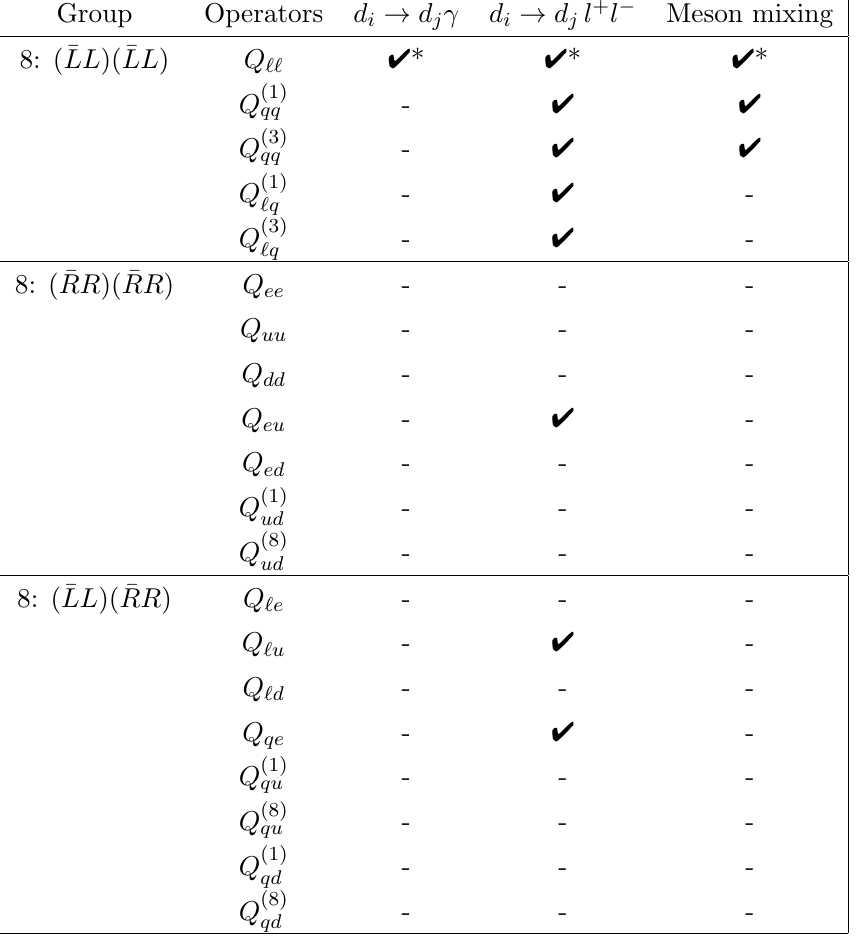
Table 2 . All four-fermion operators that are invariant under CP and the U(3) 5 (cid:13)avour symmetry. Ticks indicate that they contribute to the FCNC processes we consider. An asterisk ( (cid:3) ) signi(cid:12)es that the contribution is only indirect, via e(cid:11)ects in input parameter